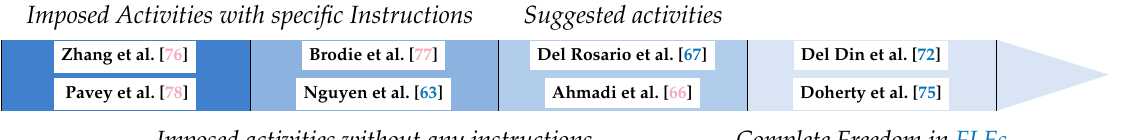
Figure 7. Frieze detailing the different types of instruction given to participants during FLEs and semi-FLEs studies. Citations colored in red are citations of semi-FLEs studies. Citations colored in blue are citations of FLEs